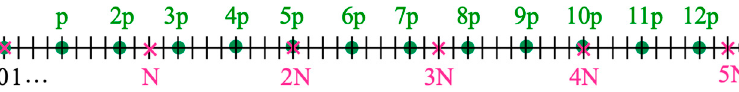
Figure 19. Multiples of N are enclosed by immediately succeeding multiples of p.